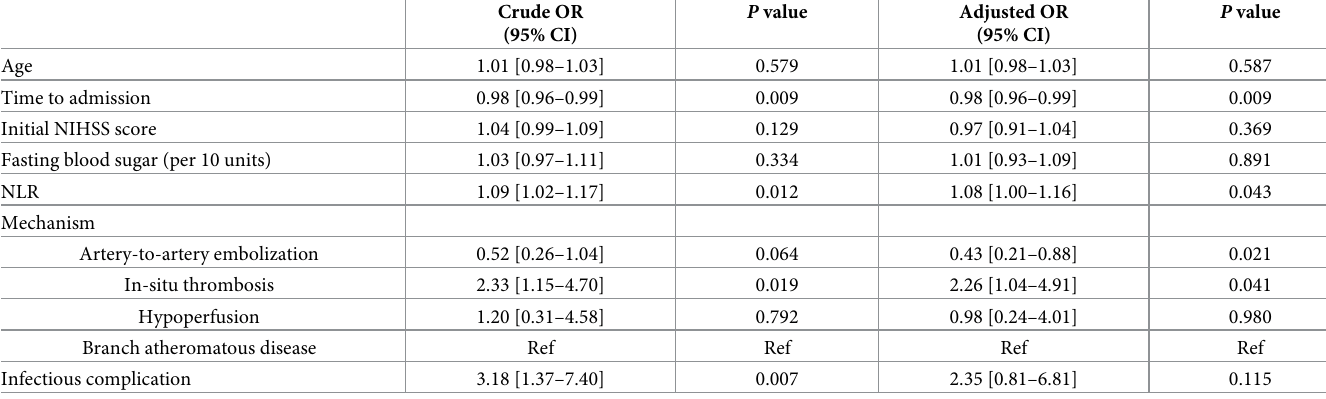
Table 2. Multivariable analyses of the relationship between early neurological deterioration and inflammatory markers with/without stratification by stroke mechanism.